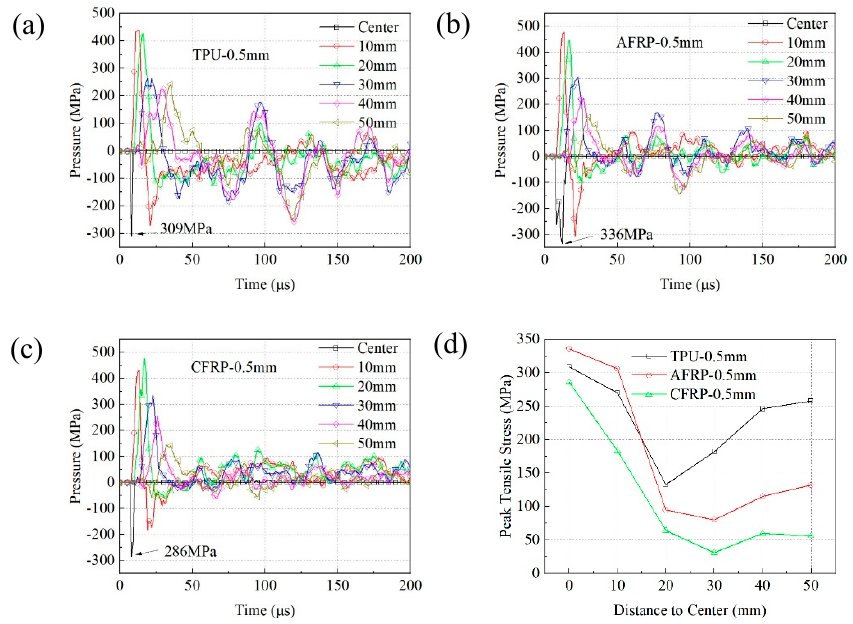
Figure 9. Curve of hydrostatic pressure in the ceramic rear surface versus time: ( a ) TPU; ( b ) Kevlar Composites; ( c ) CFRP; ( d ) relationship between peak tensile stress and position.